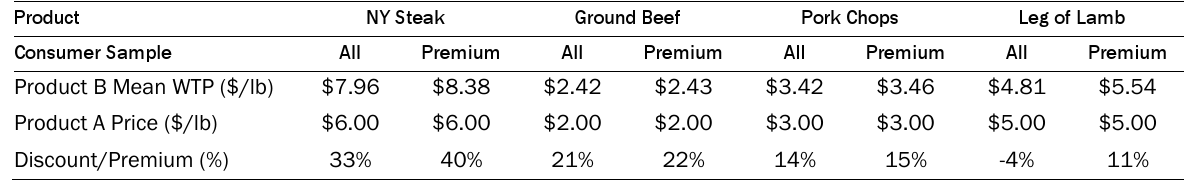
Table 3. WTP Estimates for “All” Respondents and Those Willing to Pay a “Premium” (All US$)